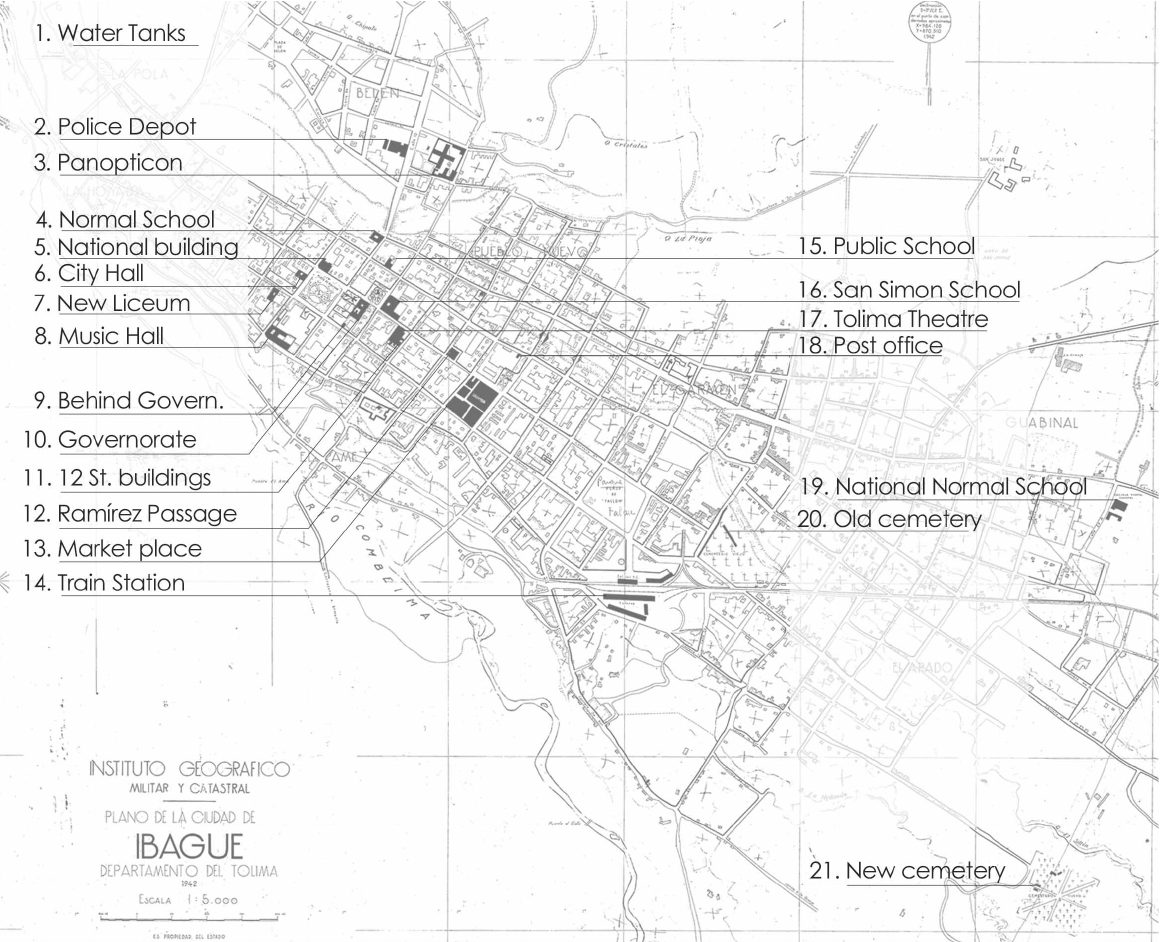
Figure 3. Monuments in 1942 with solid